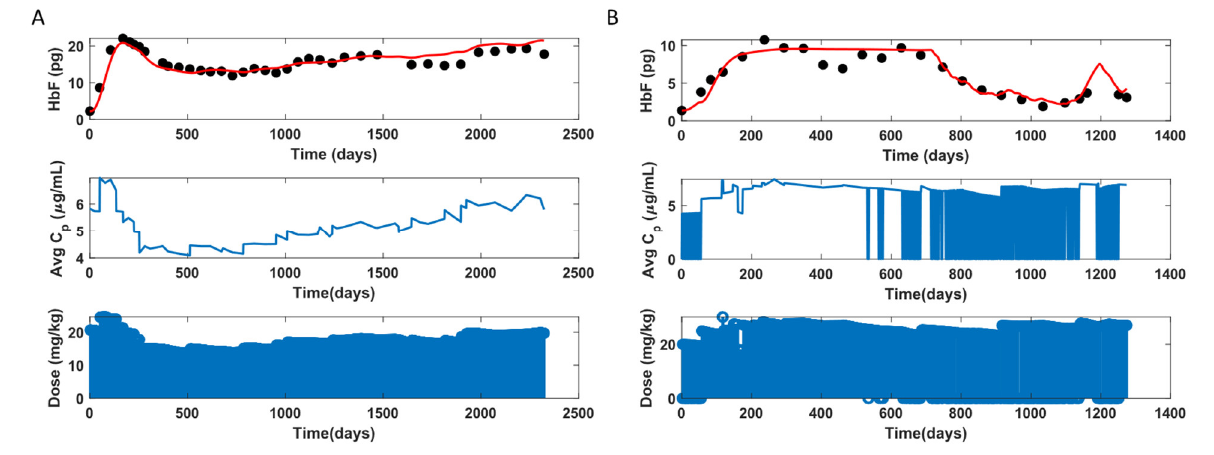
Figure 17. HbF model fit of two representative participants. ( A ): Adherent, ( B ): Non-adherent.